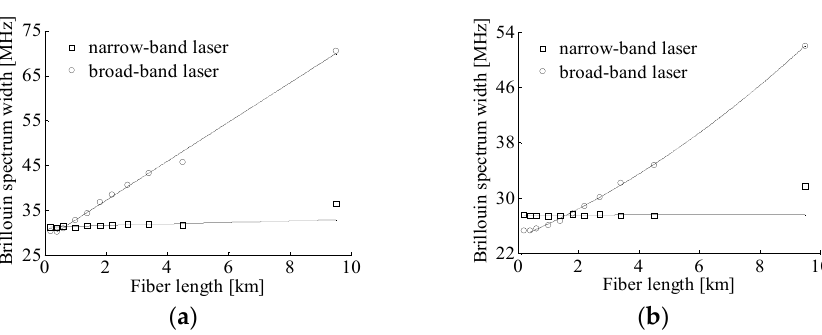
Figure 3. Brillouin spectrum width versus fiber length with different lasers: ( a ) local heterodyne detection and ( b ) self-heterodyne detection.